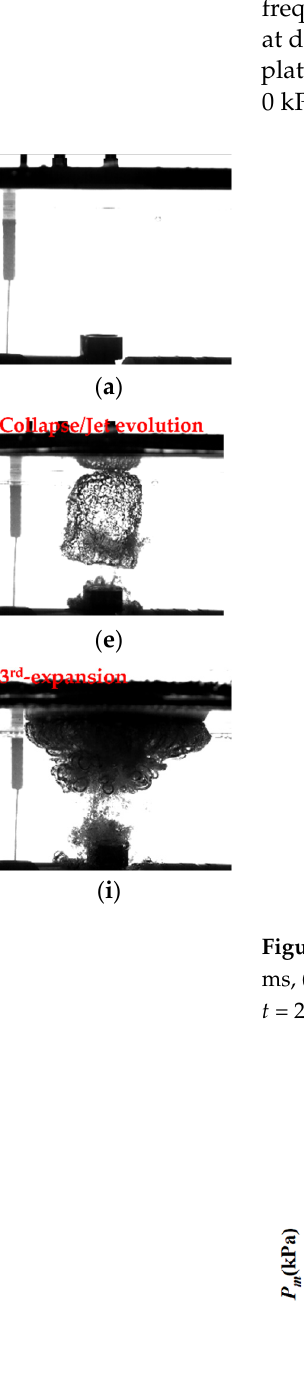
Figure 5. Schematic of dimensionless parameters.